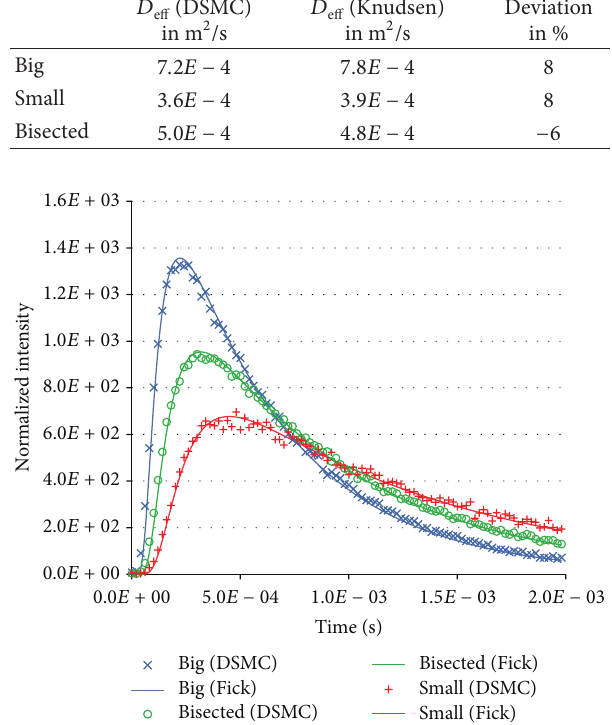
Figure 2: Simulated (DSMC) pulse response curves in comparisons to Fick’s 2nd law for three model